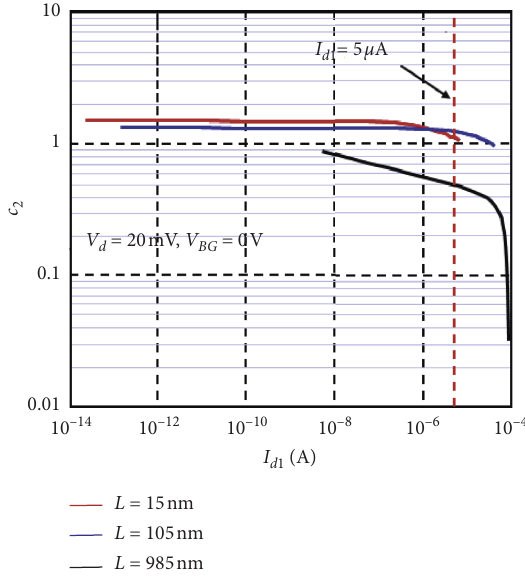
Figure 7: Coupling factor c 2 for various gate lengths as a function of drain current I d 1 , at V d � 20 mV and V BG � 0 V.